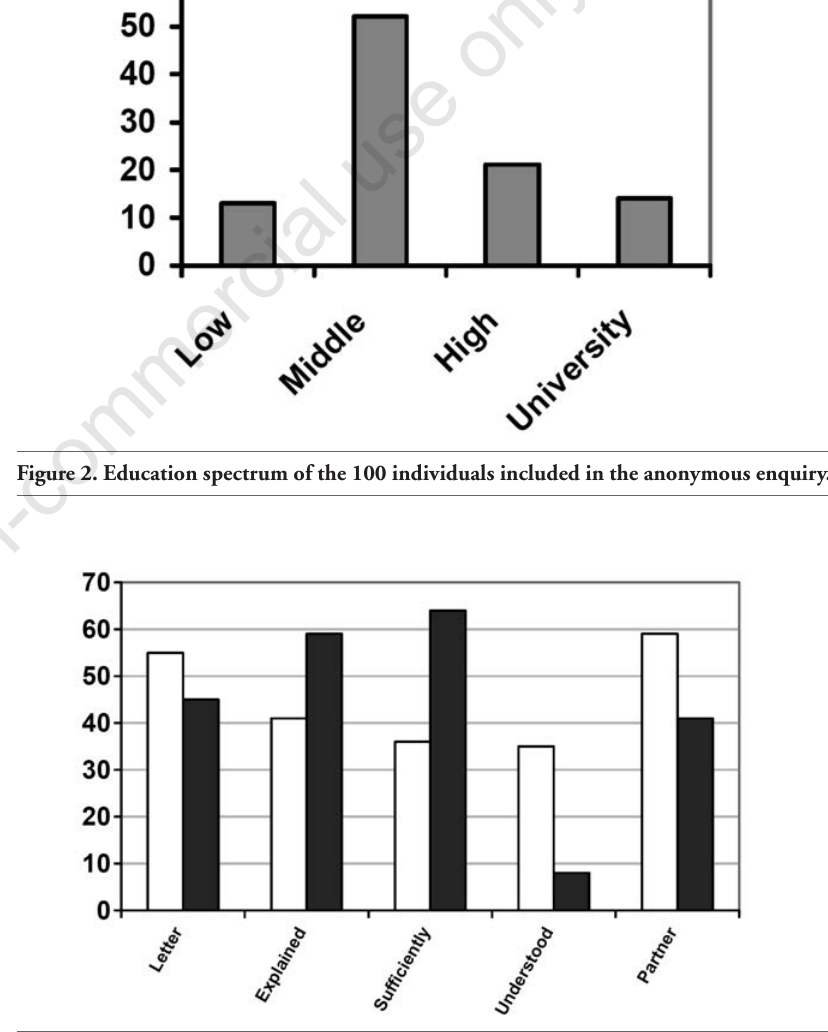
Figure 3. Information status in the 100 enquired individuals at level 1. Letter received (white)/not received (black). Letter explained (white)/not explained (black). Sufficient (white)/insufficient explanation (black). Understood (white)/not understood (black). Informed about the importance of partner analysis (white)/not informed